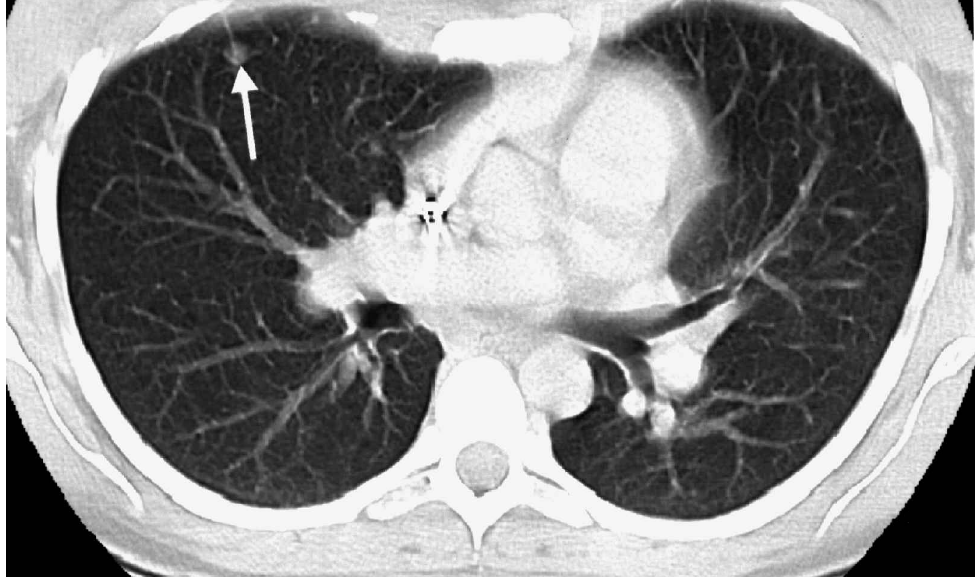
Figure 2. A 21-year-old female with Ewing’s sarcoma of left pelvis. CT at presentation showed three subcentimeter lung nodules. Helical CT image demonstrates one 0.7 3 0.6 cm nodule (arrow) in the right middle lobe, which at resection represented a benign lymph node.All three nodules were benign at biopsy, demonstrating alveolar ® brosis, atelectasis and unremarkable lymphoid tissue.